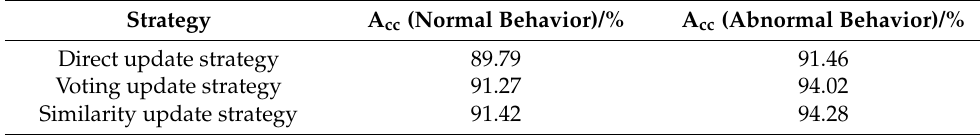
Table 3. Ablation experiments of three strategies.